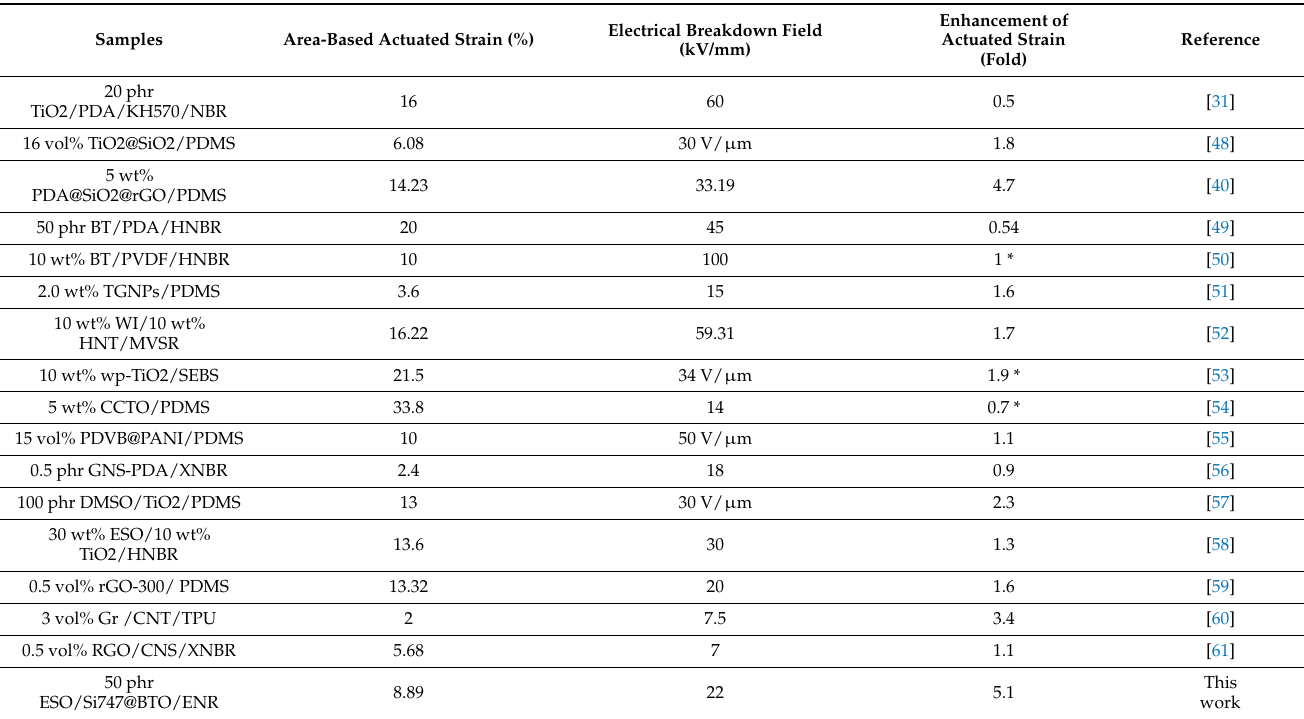
Figure 11. The actuated strain of 50 phr ESO/Si747@BTO/ENR DEA under a cyclic electric field of 15 kV/mm. Table 1. Values of the actuation performance of different DEs, without pre-strain, reported in previous works and the present